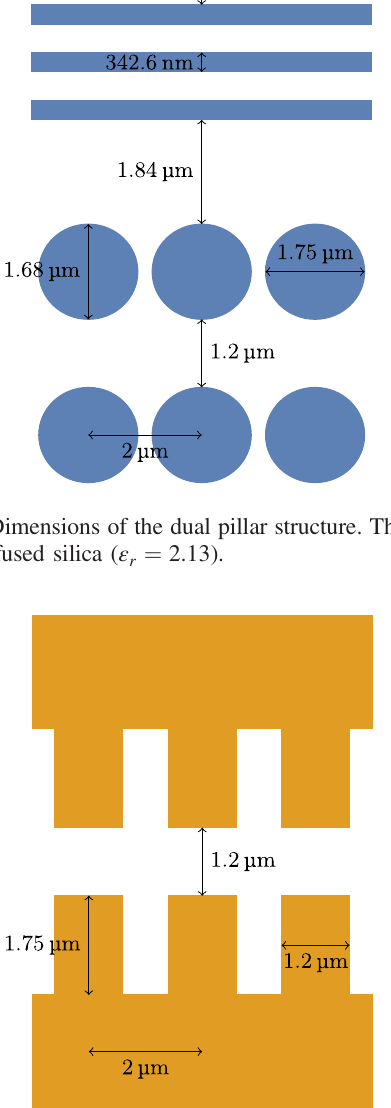
FIG. 15. Dimensions of the dual-layer rectangular grating structure. The structure is made of fused silica ( ε r ¼ 2 . 13 ) and the height of the substrate is much larger than the period length to avoid effects of a defined substrate thickness on the short-range